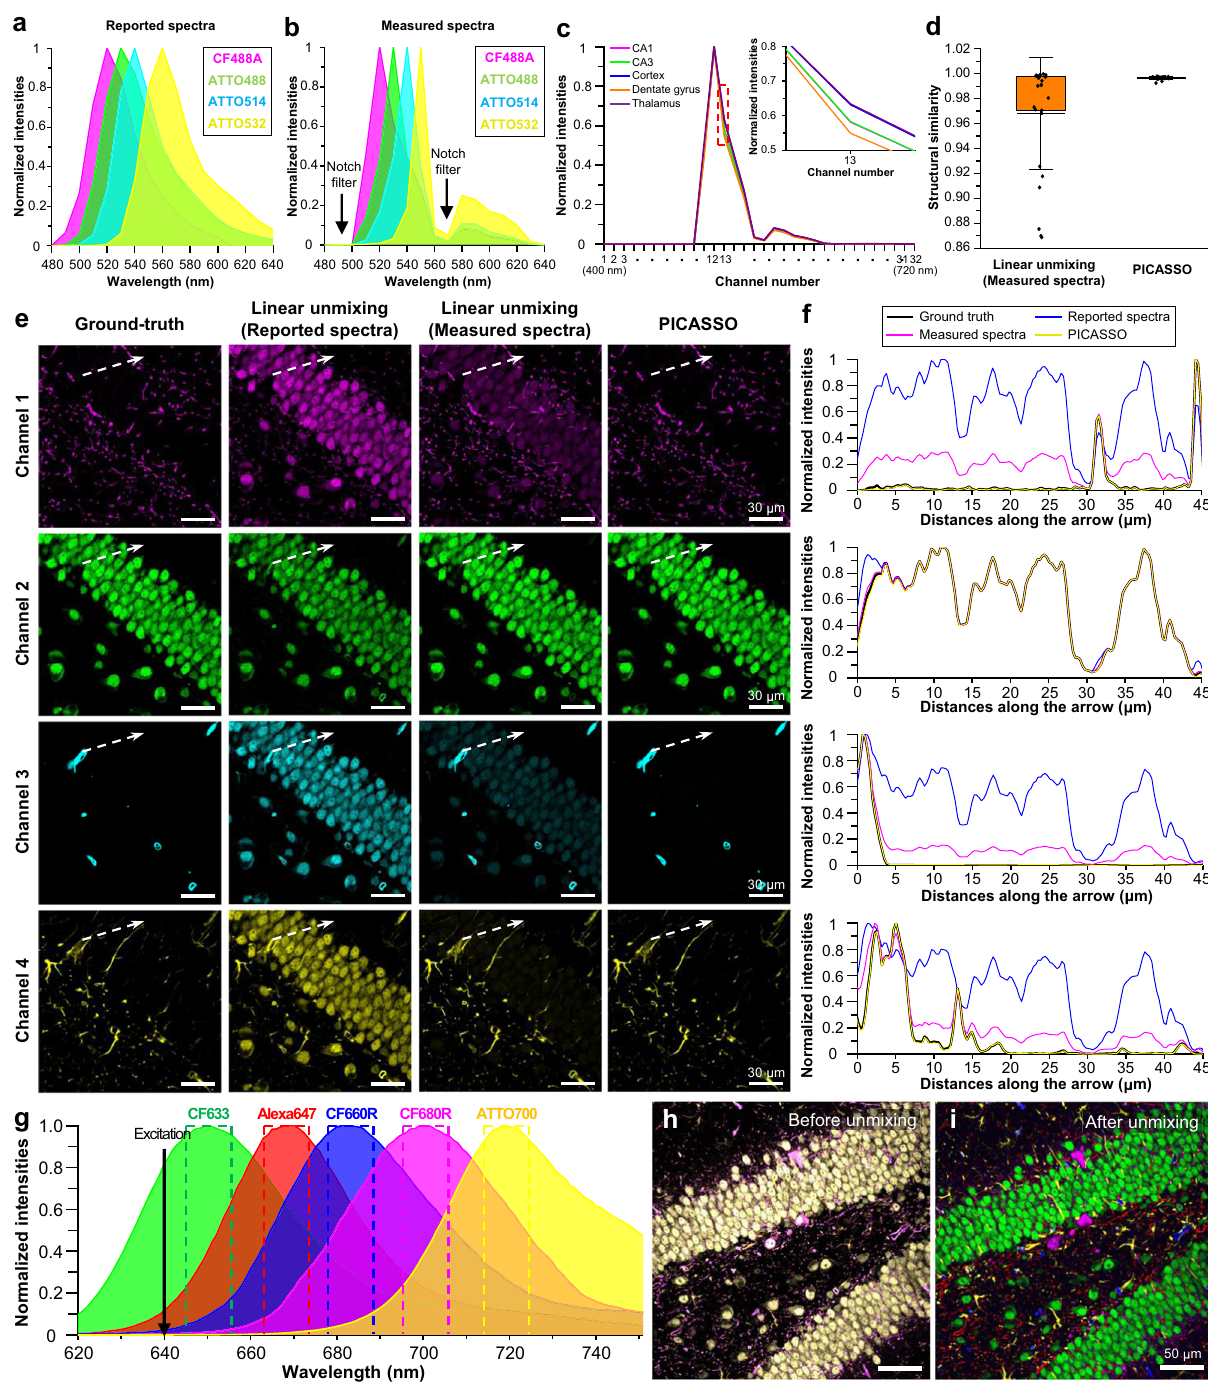
simultaneously excited by a 640-nm laser were selected. A mixing matrix was then generated by calculating the contribution of the fl uorophores in fi ve detection channels, each of which was de fi ned from − 5 to + 5 nm of the emission maximum of each fl uorophore (Fig. 2g). The synthetic mixed images were generated by mixing a fi ve-color source image of a mouse brain slice with one channel each to correspond to NeuN, CNP1, GluT1, parvalbumin (PV), and GFAP with Gaussian additive noise (Fig. 2h). The noise level was determined by imaging a droplet of fl uorophore solution with the same microscopy setup and imaging conditions. The synthetic images were fed to PICASSO